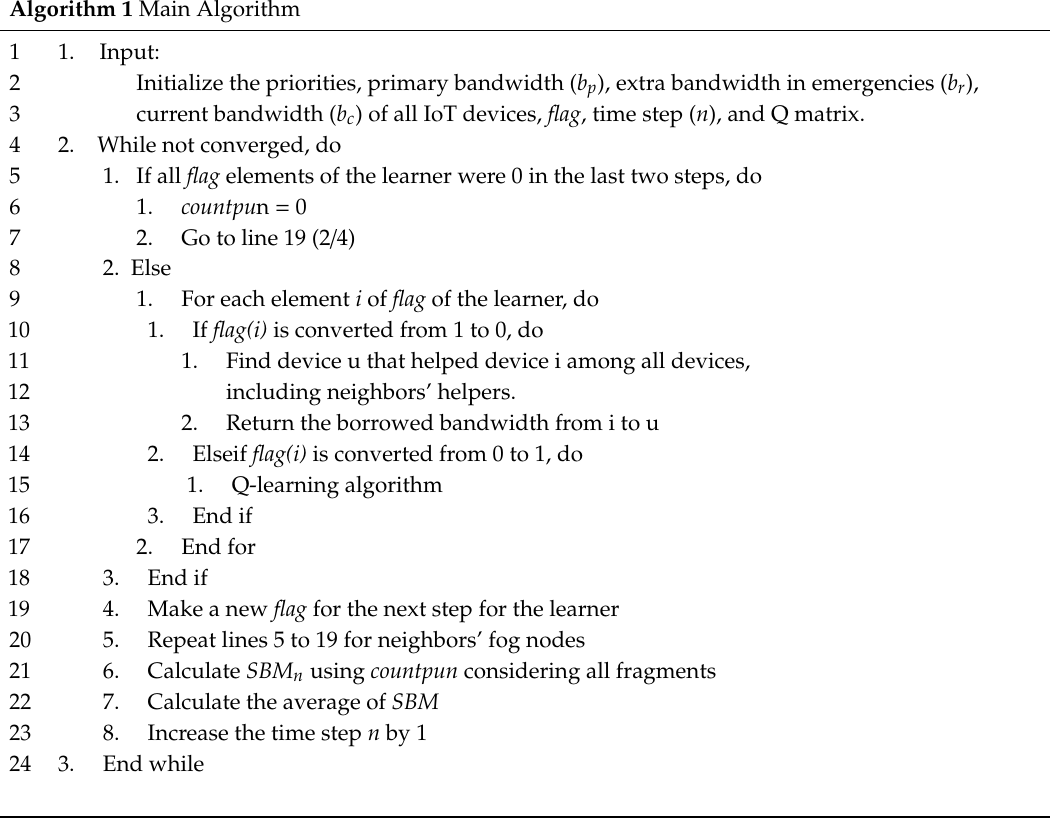
Algorithm 1 Main